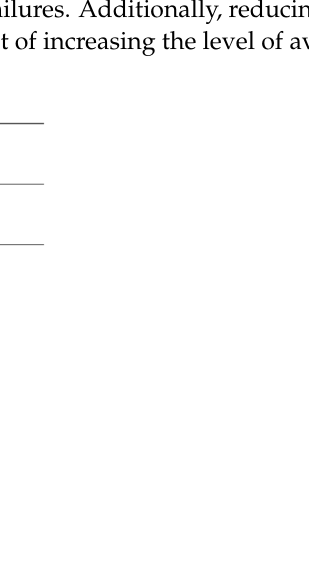
Figure 6. LV SPER systems: ( a ) typical configuration and ( b ) an example of multiple parallel SAs per voltage line configuration (proposed in this work).